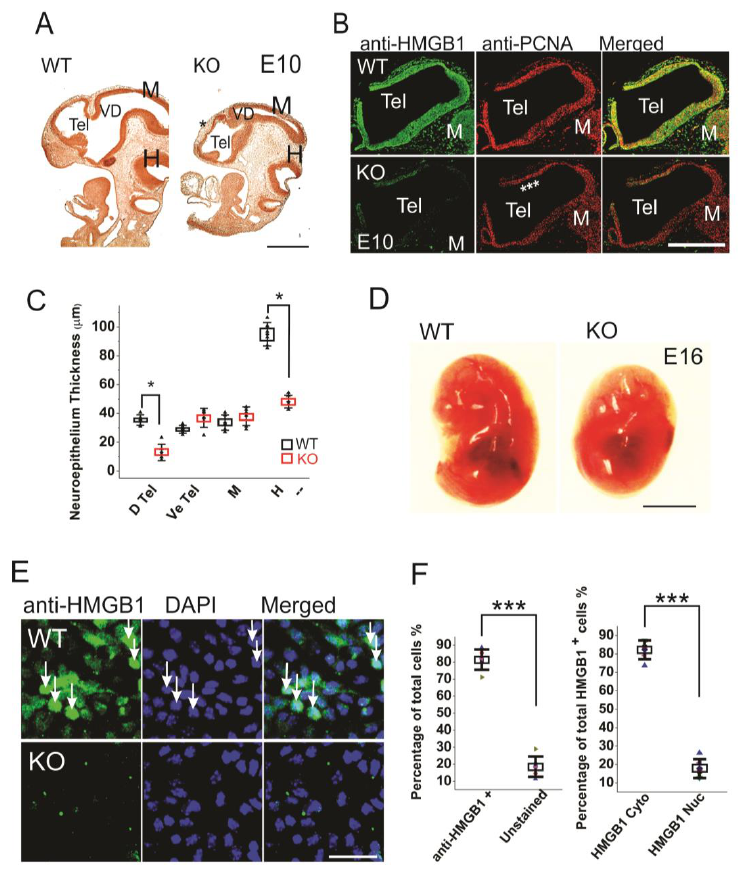
Figure 1. Morphogenesis and proliferation defects of the prenatal HMGB1 knockout (KO) mouse. ( A ) Bromodeoxyuridine (BrdU) stained sagittal sections of the E10 embryo from the HMGB1 KO and the WT control. The decreased BrdU staining in the dorsal neopallial cortex is indicated with *. Scale bar indicates 500 µ m. ( B ) Whole mount immunostaining of sagittal sections of E10 dorsal telencephalon with anti-HMGB1 (Green) and anti-PCNA (Red) antibodies. HMGB1 was not detected in the HMGB1 KO. PCNA staining was grossly decreased in the rostral anterior part of the dorsal telencephalon (indicated with ***). Scale bar indicates 400 µm. ( C ) Statistics of the thickness of E10 neuroepithelium. The BrdU stained sections from six KO and six WT embryos were compared. The HMGB1 KO showed significantly decreased BrdU staining in dorsal telencephalic ventricle and hindbrain. D Tel, dorsal telencephalic ventricle; Ve Tel, ventral telencephalic ventricle; M, midbrain; H, hindbrain. Mean values ± S.D. (error bars) and S.E.M (Boxes) are indicated ( n = 6; * p < 0.001, unpaired t -test, two-tailed). ( D ) Lateral view of the E16 KO and the WT embryos. Scale bar indicates 5 mm. ( E ) Immunofluorescent staining of in vitro one day cultured E16 cortical neurons with anti-HMGB1 antibody (Green). Arrows show cells with high HMGB1 expression in nucleus. Scale bar indicates 20 μm. ( F ). The statistics of HMGB1 expressing cells in cultured E16 cortical neurons. The cortical neurons from five KO and five WT E16 brains were collected. Mean values ± S.D. (error bars) are indicated ( n = 5; *** p < 0.001, unpaired t -test, two-tailed).